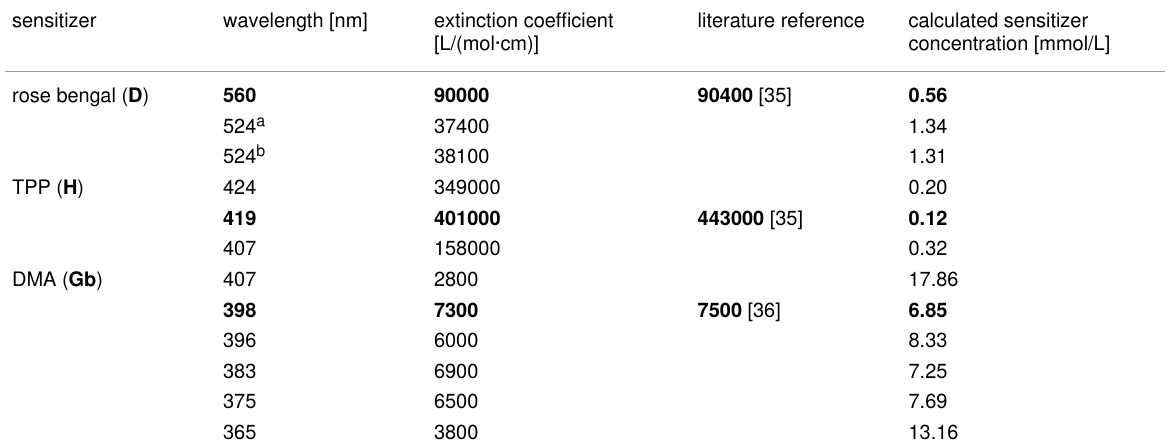
Table 1: Measured extinction coefficients and estimated ideal catalyst concentrations.